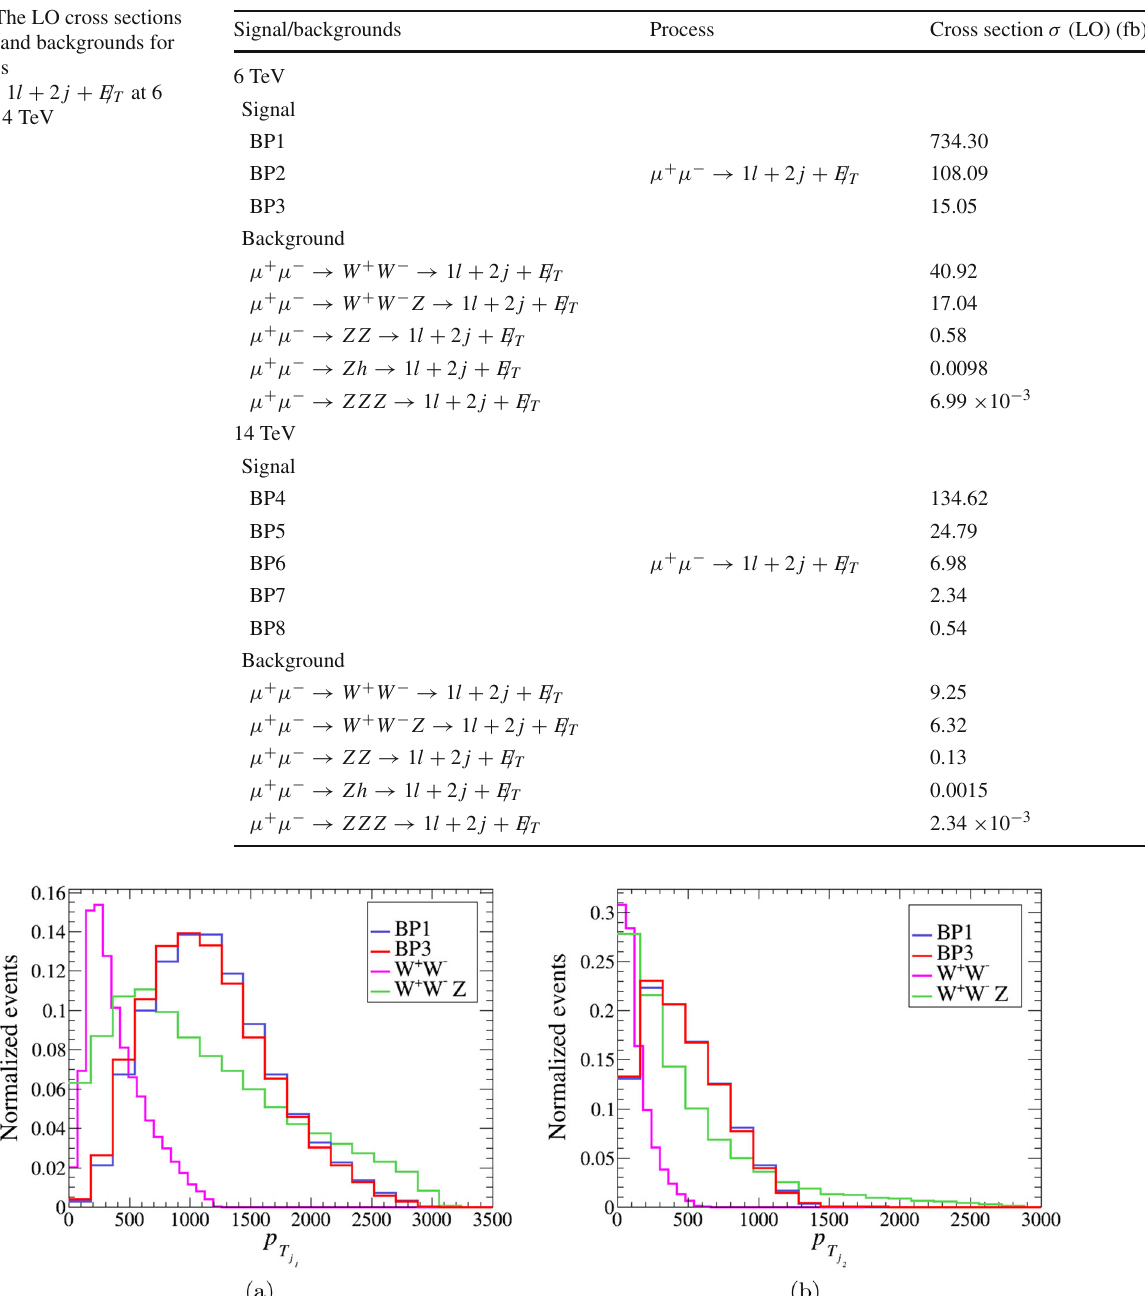
Fig. 7 Normalized distributions of the kinematic variables a p T muon